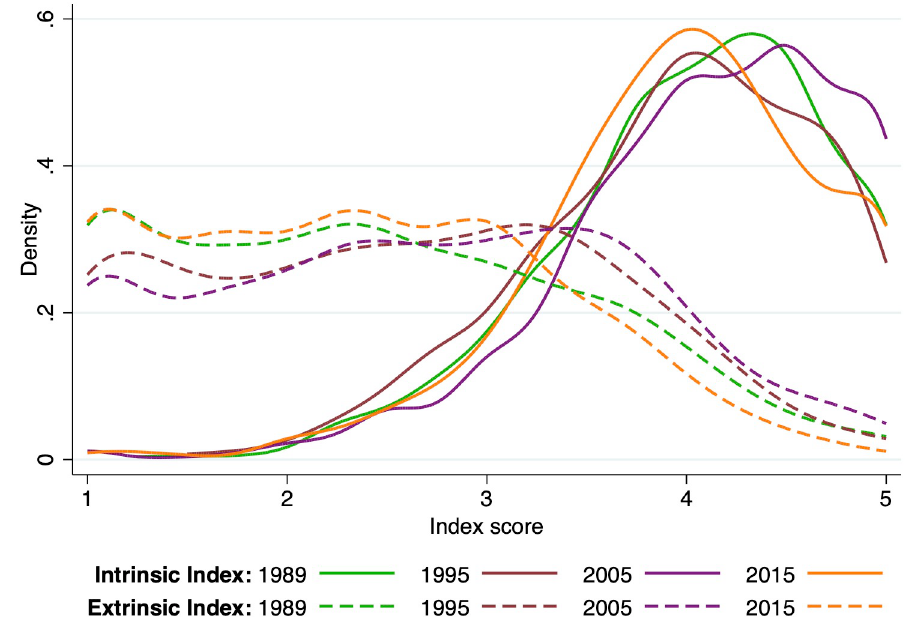
Fig 3. Distribution of attitudes and values indexes, by year. This figure displays the distribution of the two indexes by year. The solid lines correspond to the intrinsic index and the dashed line corresponds to the extrinsic index. To construct the indexes, we averaged the items scores within individual and within each grouping resulting from the factor analysis to create an index. More details can be found in the Materials and methods section. N = 3,047.